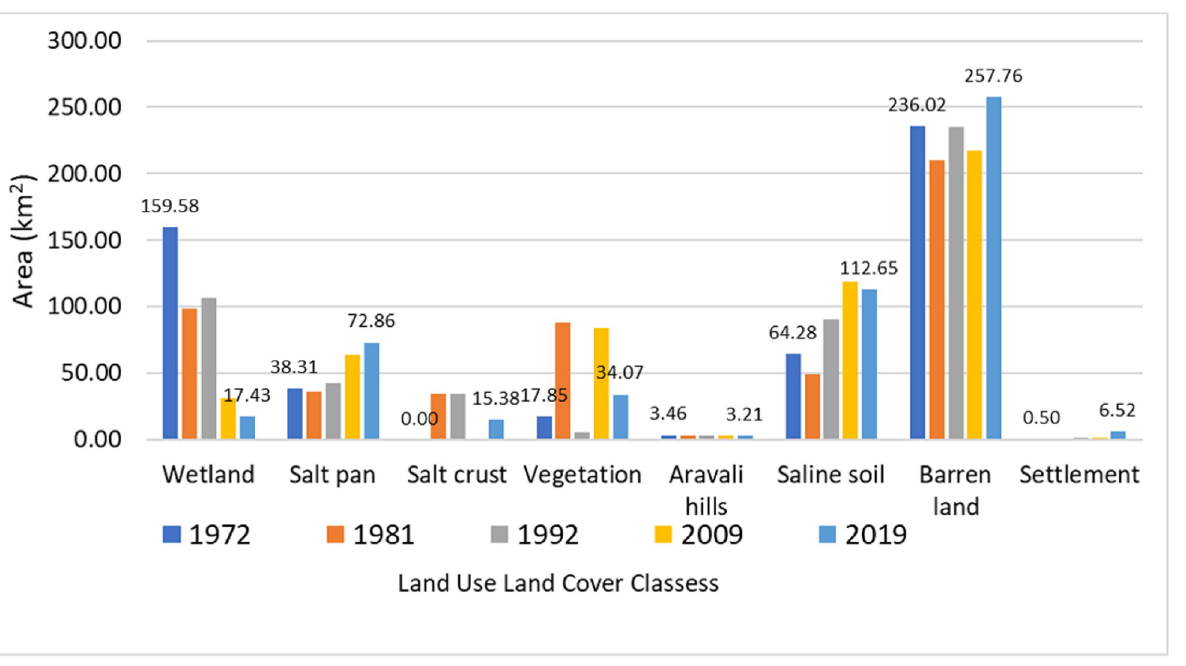
Fig 6. Graph of LULC